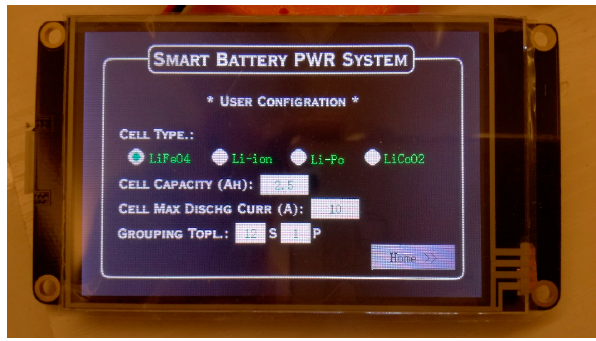
Figure 11. Configuration page of GUI for proposed battery-power system.